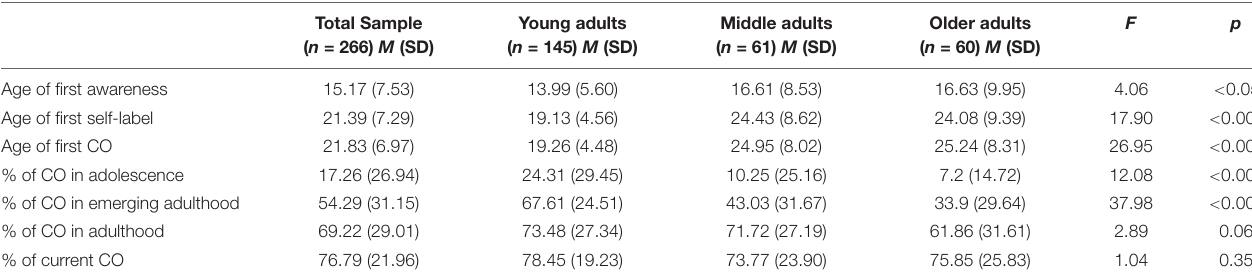
TABLE 2 | Sexual orientation milestones in young, middle, and older LGBQ+